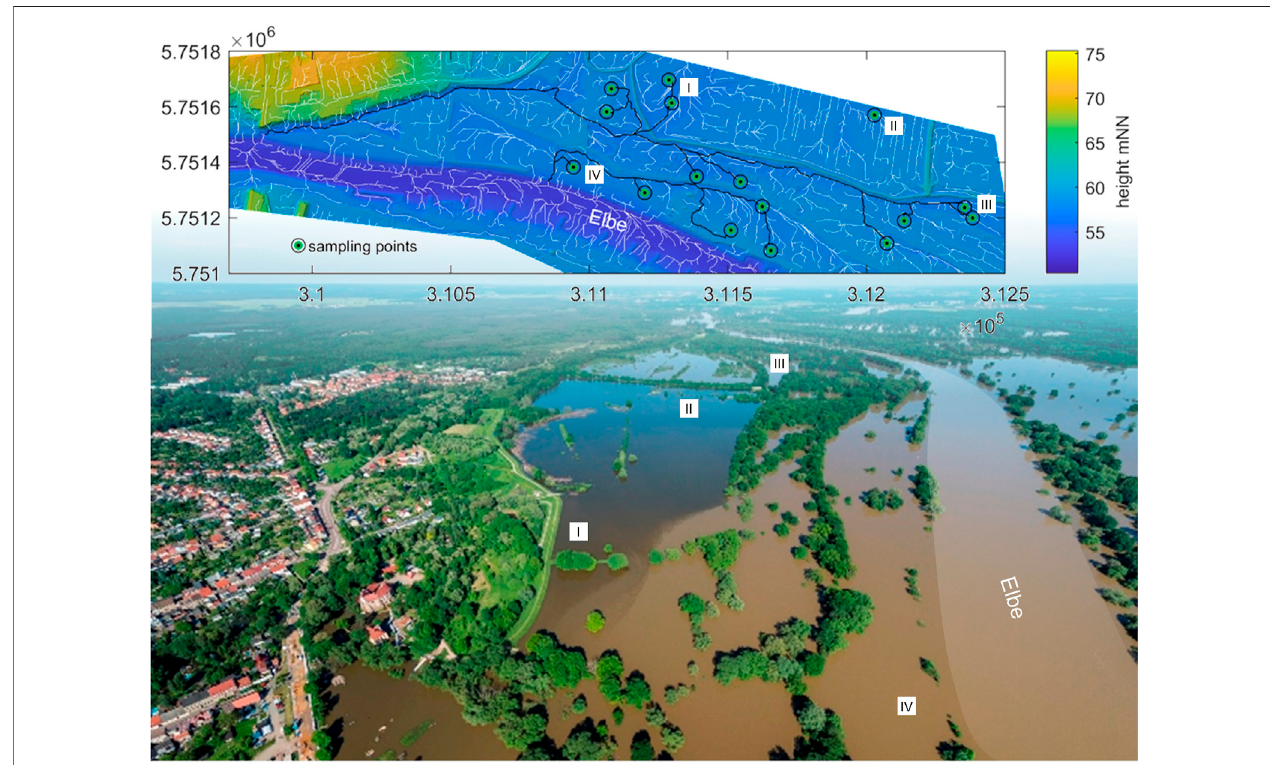
FIGURE 2 | Hydrological connectivity of investigated plots for the Elbe_R (ER). Black lines show calculated fl ow paths based on the DEM using the fl ow accumulation approach from TopoToolbox2 in MATLAB. The dike was slit, hence two of the plots behind are connected (I), and one is not (II, no black line). This is con fi rmed by a helicopter photo (André Künzelmann/UFZ) of a fl ood event showing river water and groundwater behind the opened dike.